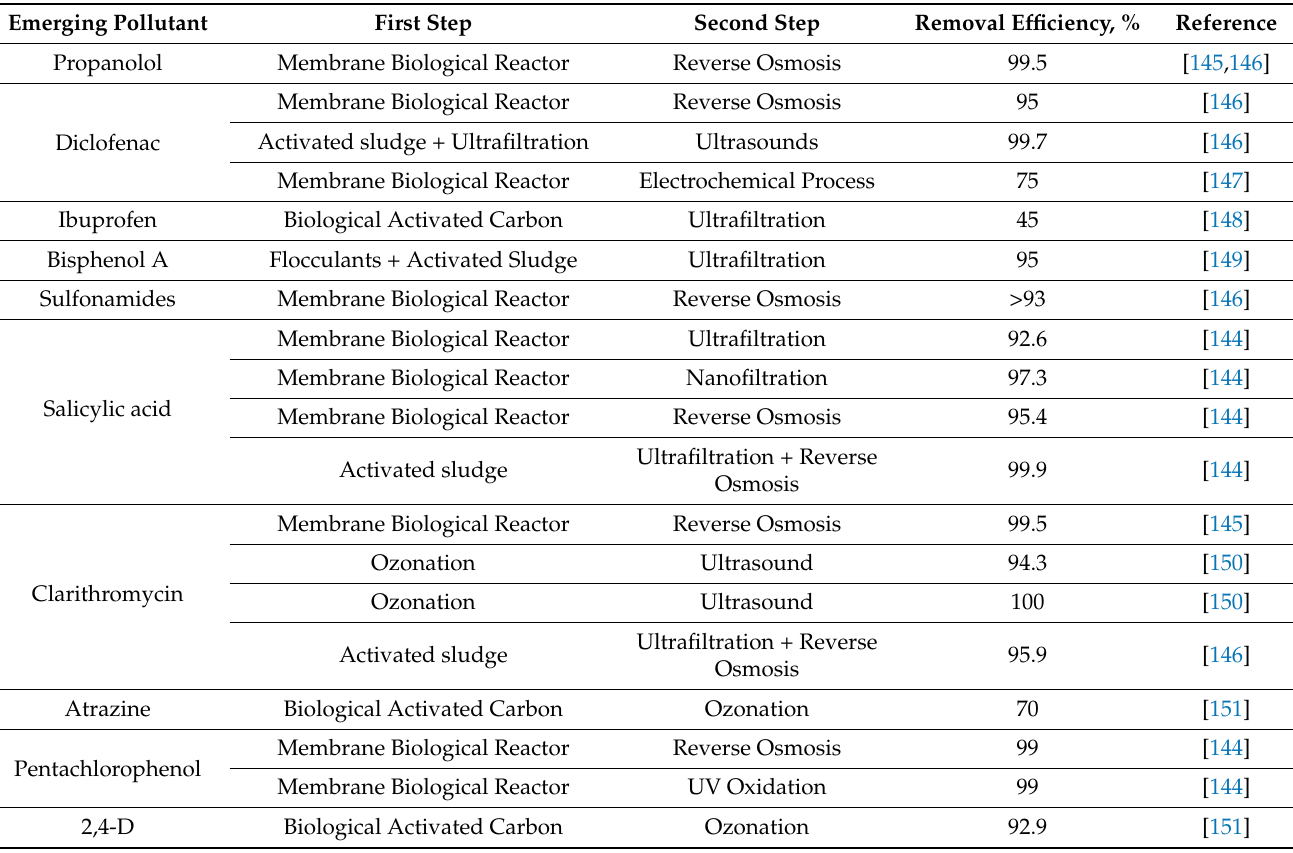
Table 10. Efficiency of EP removal achieved by hybrid